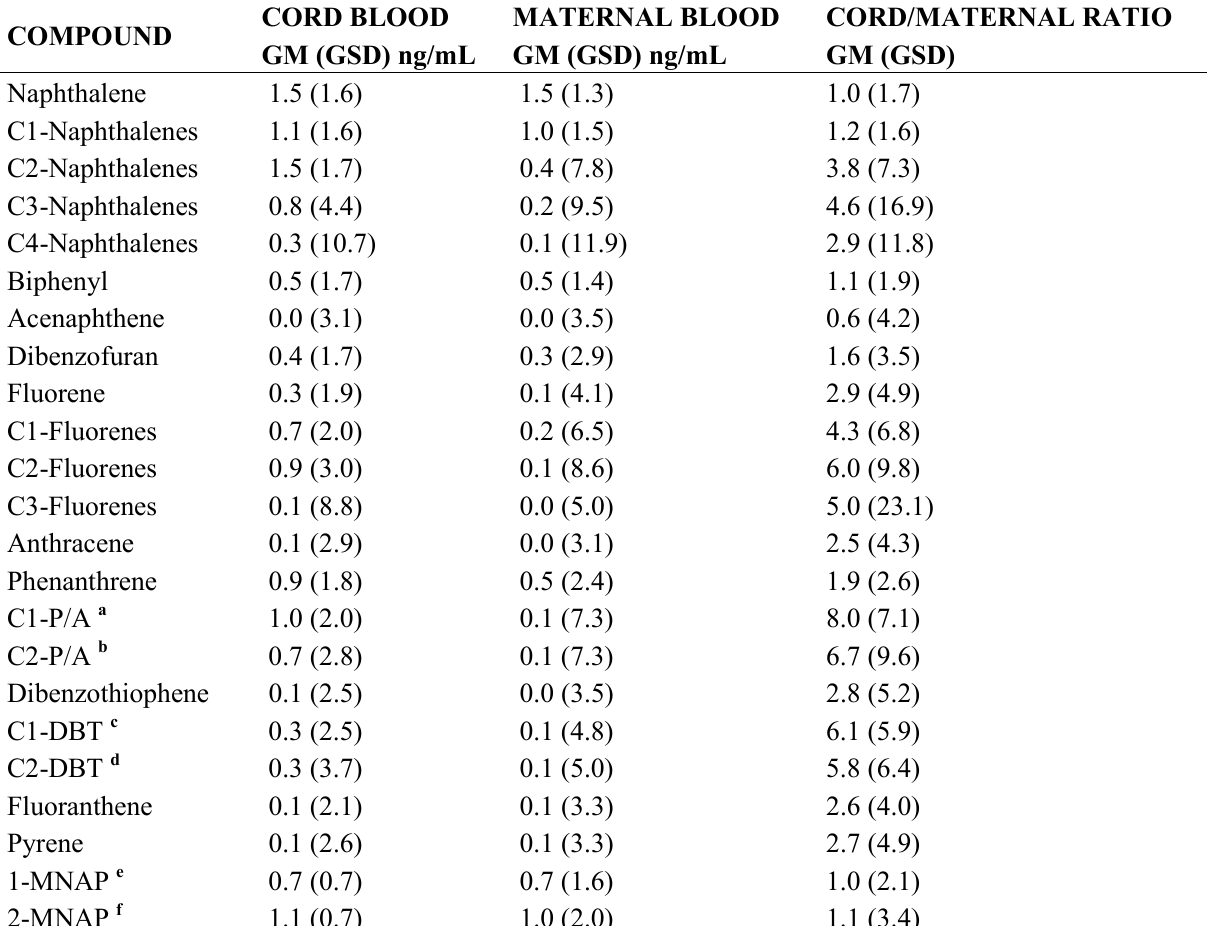
Table 3. Summary statistics for PAH concentrations in matched pairs of maternal and cord blood (N =